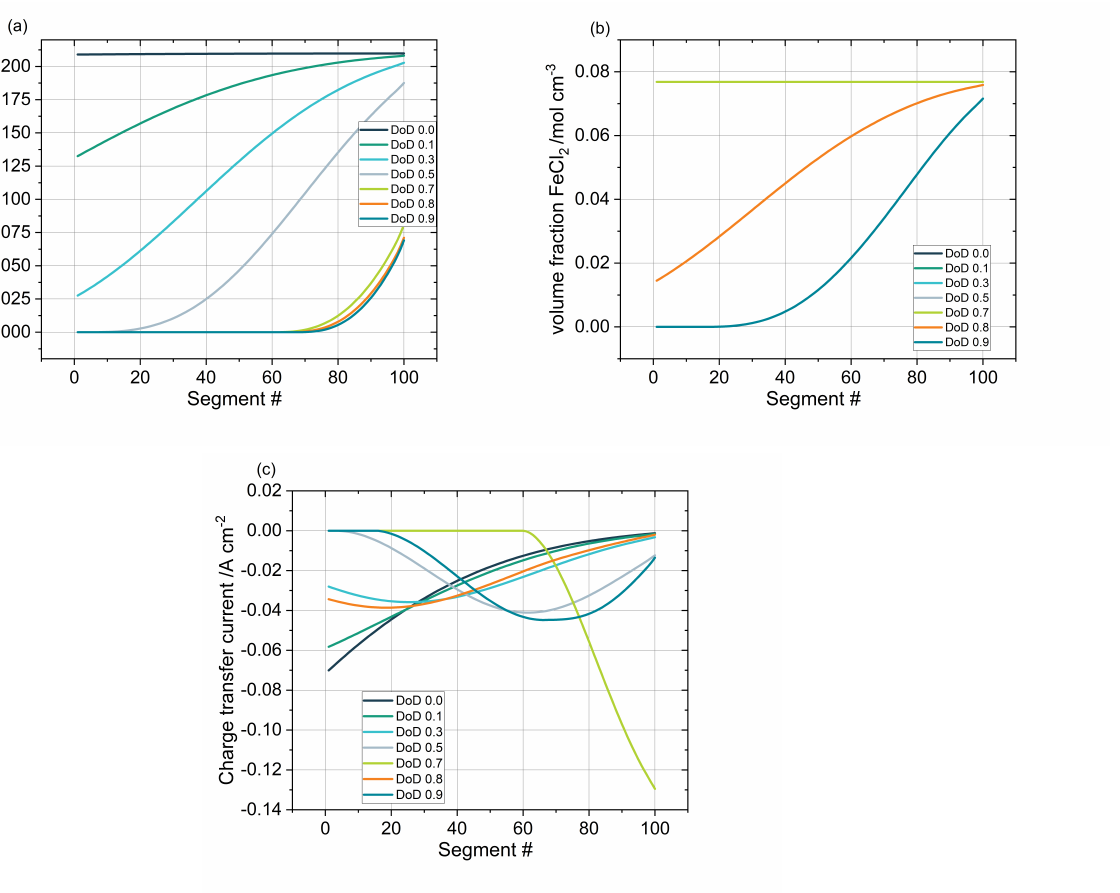
Figure 7. ( a ) Volume fraction distribution of NiCl 2 over the segments 0 − 100 for different DoDs. ( b ) Volume fraction distribution of FeCl 2 over the segments 0 − 100 for different DoDs. ( c ) Calculated charge transfer current for the corresponding DoDs shown in ( a , b